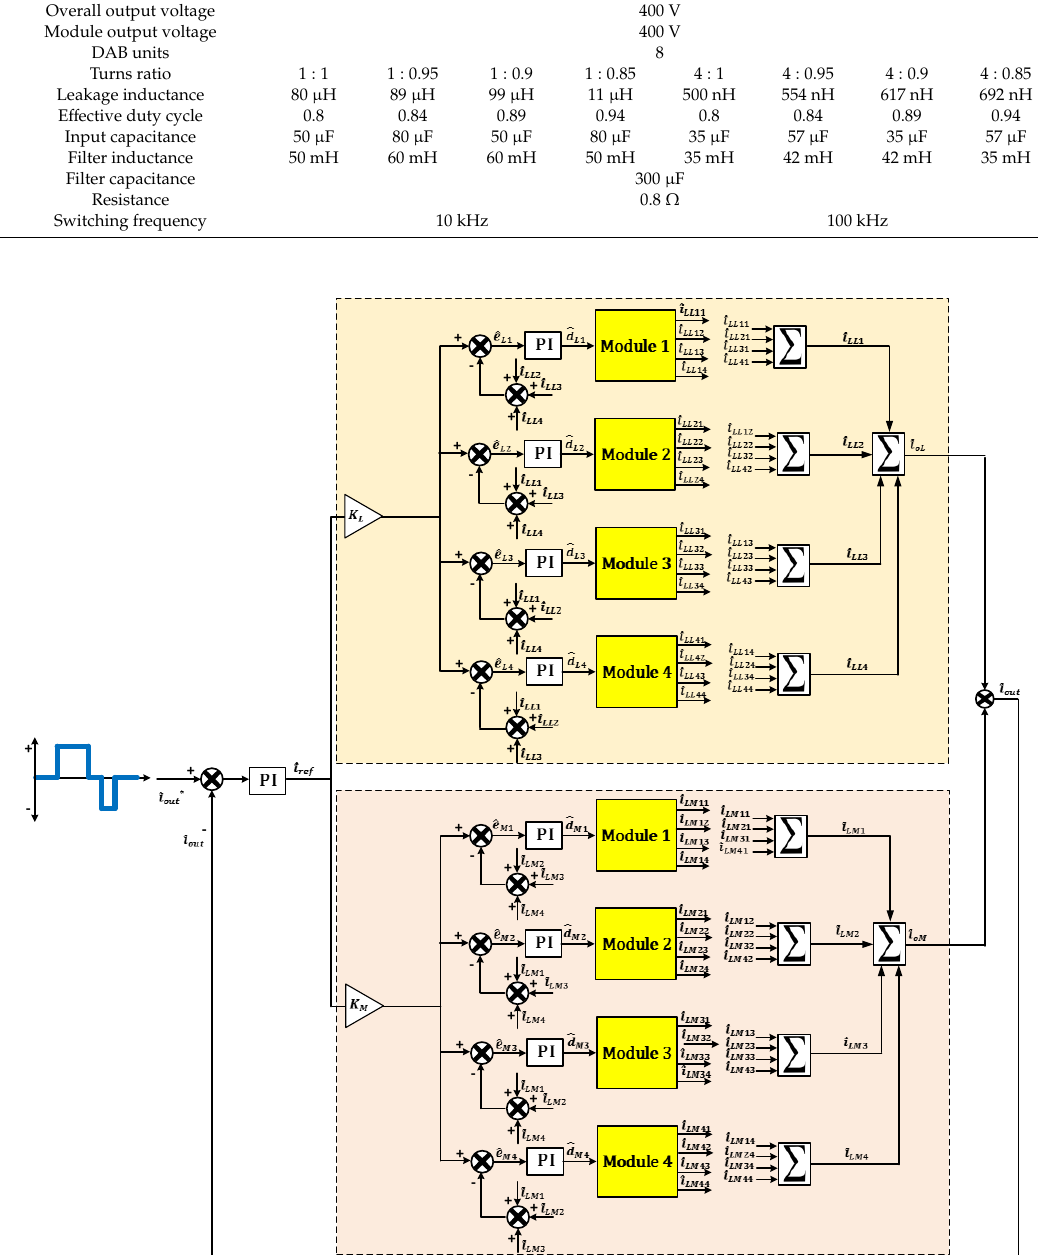
Figure 10. OCS control scheme for the proposed hybrid ISOP DC-DC converter.